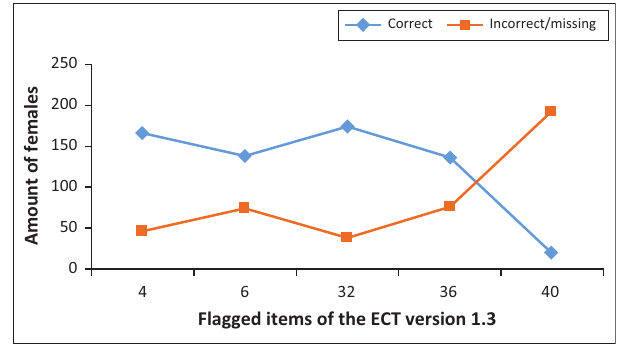
FIGURE 1: Female performance on flagged items of English Comprehension Test, version 1.3.